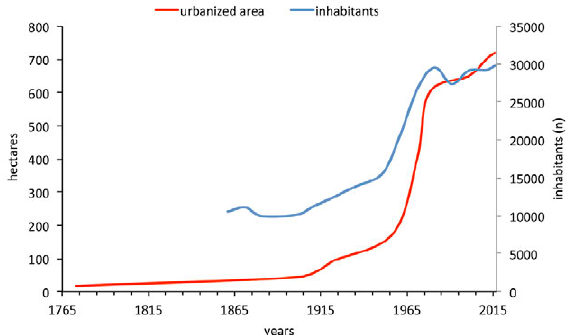
Fig. 11. Inhabitants and urbanization evolution of Rapallo